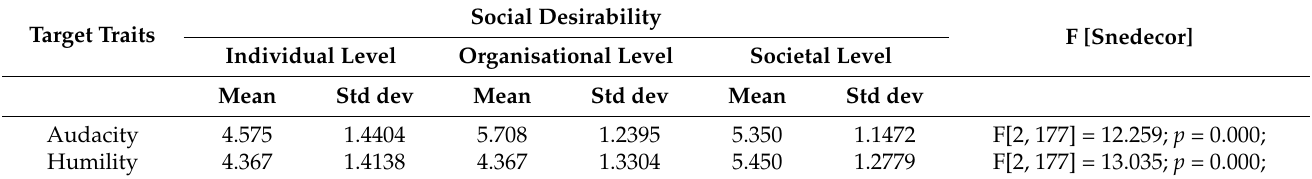
Table 4. Means and effects of context on social desirability.